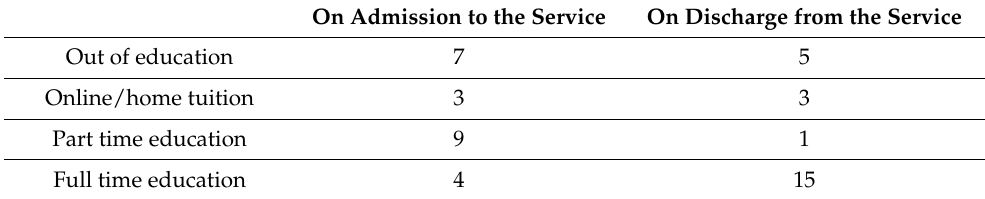
Table 5. Participation in